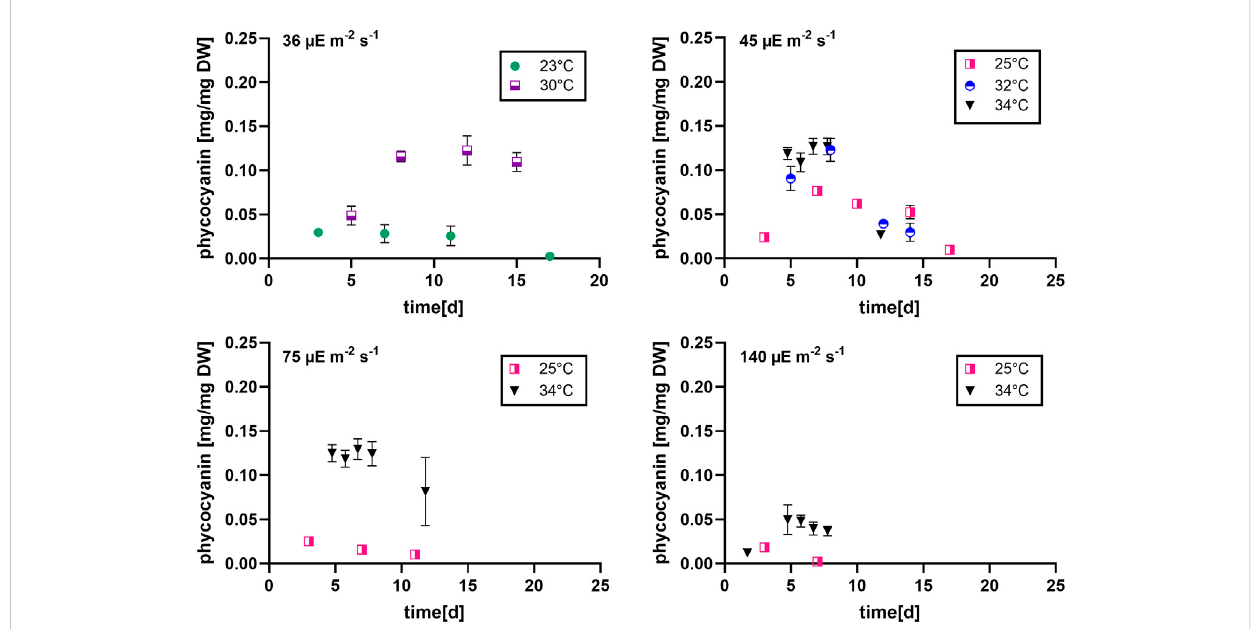
FIGURE 4 Phycocyanin content at different light intensities (36, 45, 75 and 140 µmol photons m -2 s -1 ) over the culturing time, n = four to eight, all values are presented as mean ± SD.